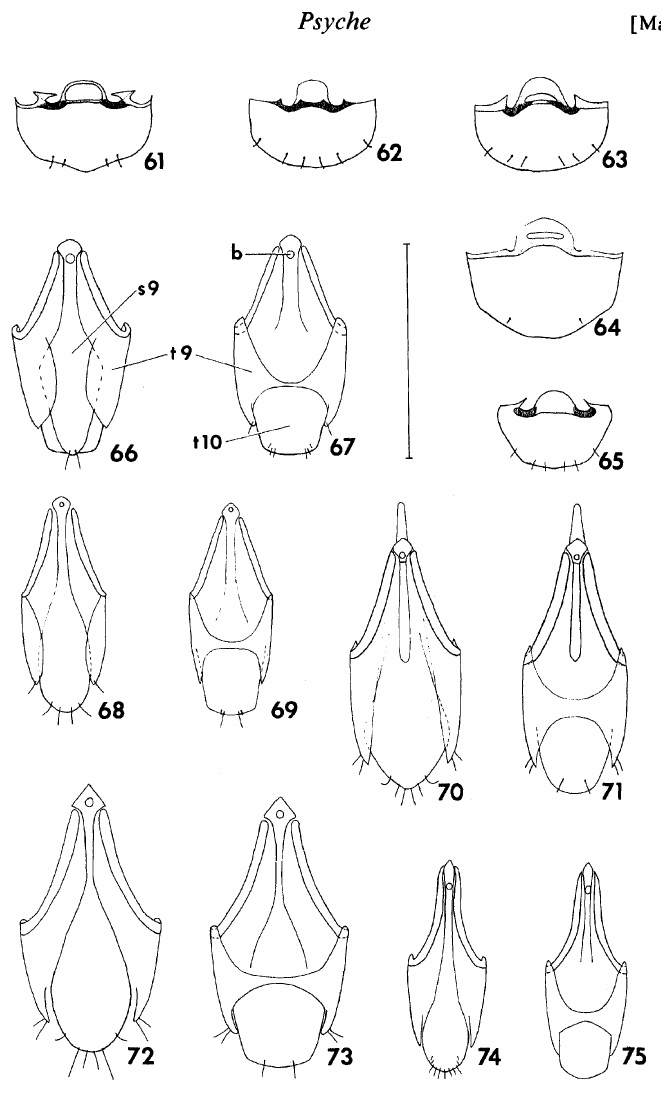
Figs. 61-75. Glypholoma spp. 61-65. Abdominal sternite 8, ventral view; 61, G. pustuliferum; 62, G. pecki; 63, G. temporale; 64, G. tenuicorne; 65, G. rotundulum. 66-75. Male genital segment, ventral and dorsal views, respectively; 66-67, G. pustuliferum; 68-69, G. pecki; 70-71, G. temporale; 72-73, G. tenuicorne; 74-75, G. rotundulum, b internal cylindrical "button"; s9 stermte 9; t9 tergite 9; tl0 tergite 10. Scale line 0.5